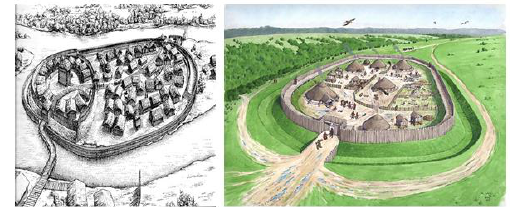
Figure 1. Typical construction of Slavic settlements (N1, N2) For the remote detection of field structures representing the area of the old fortifications may be used topographic map, aerial photography, UAV imagery or altitude data obtained e.g.